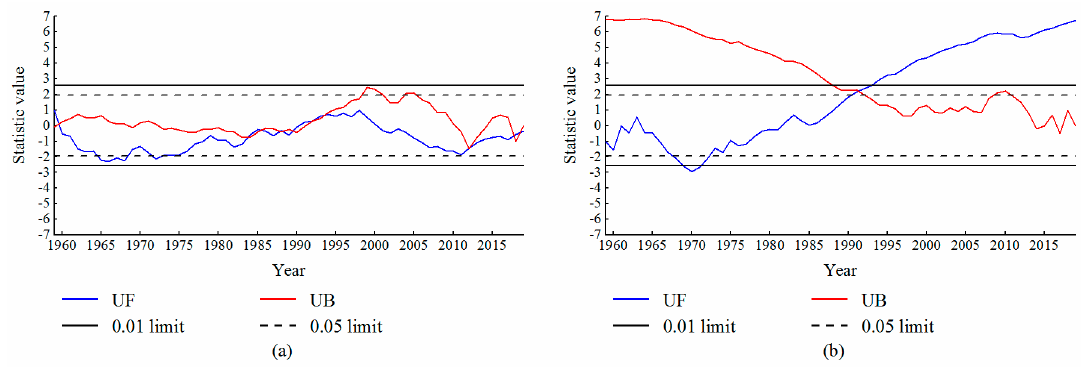
Figure 10. The M-K test results of ( a ) annual average precipitation, and ( b ) annual average